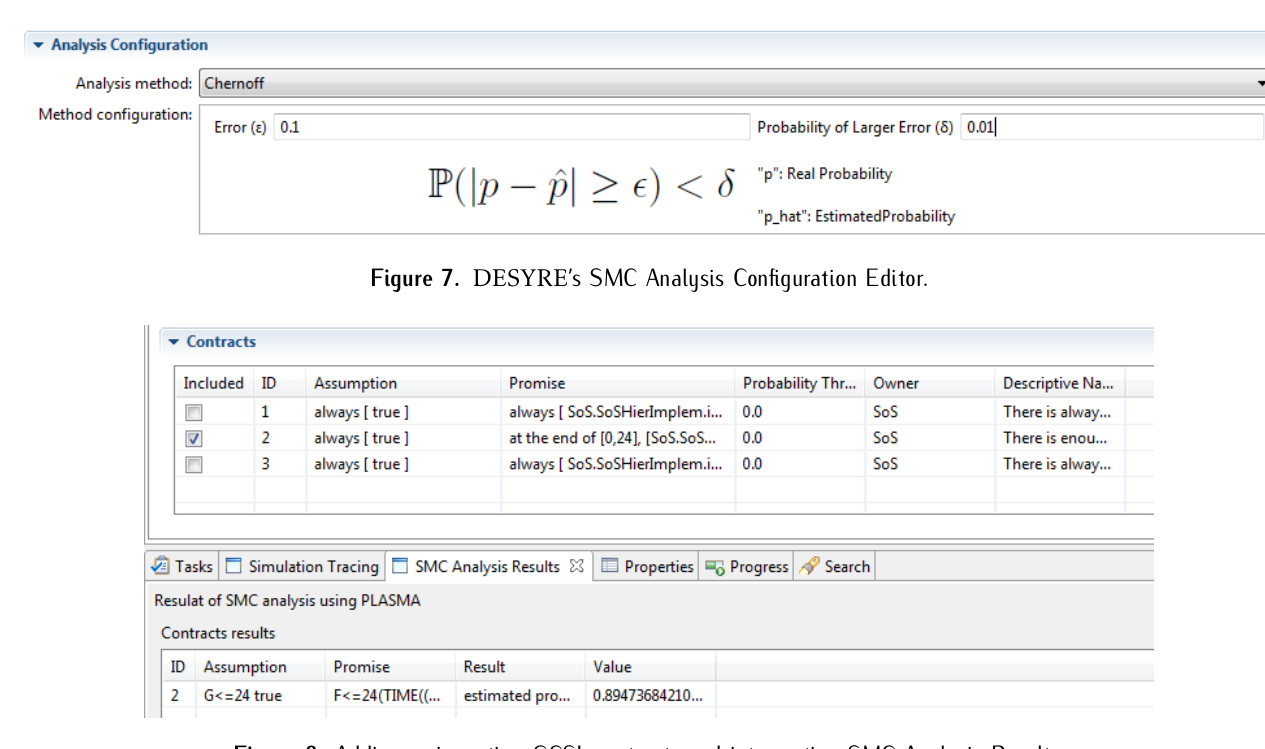
Figure 8. Adding or importing GCSL contracts and interpreting SMC Analysis Results.